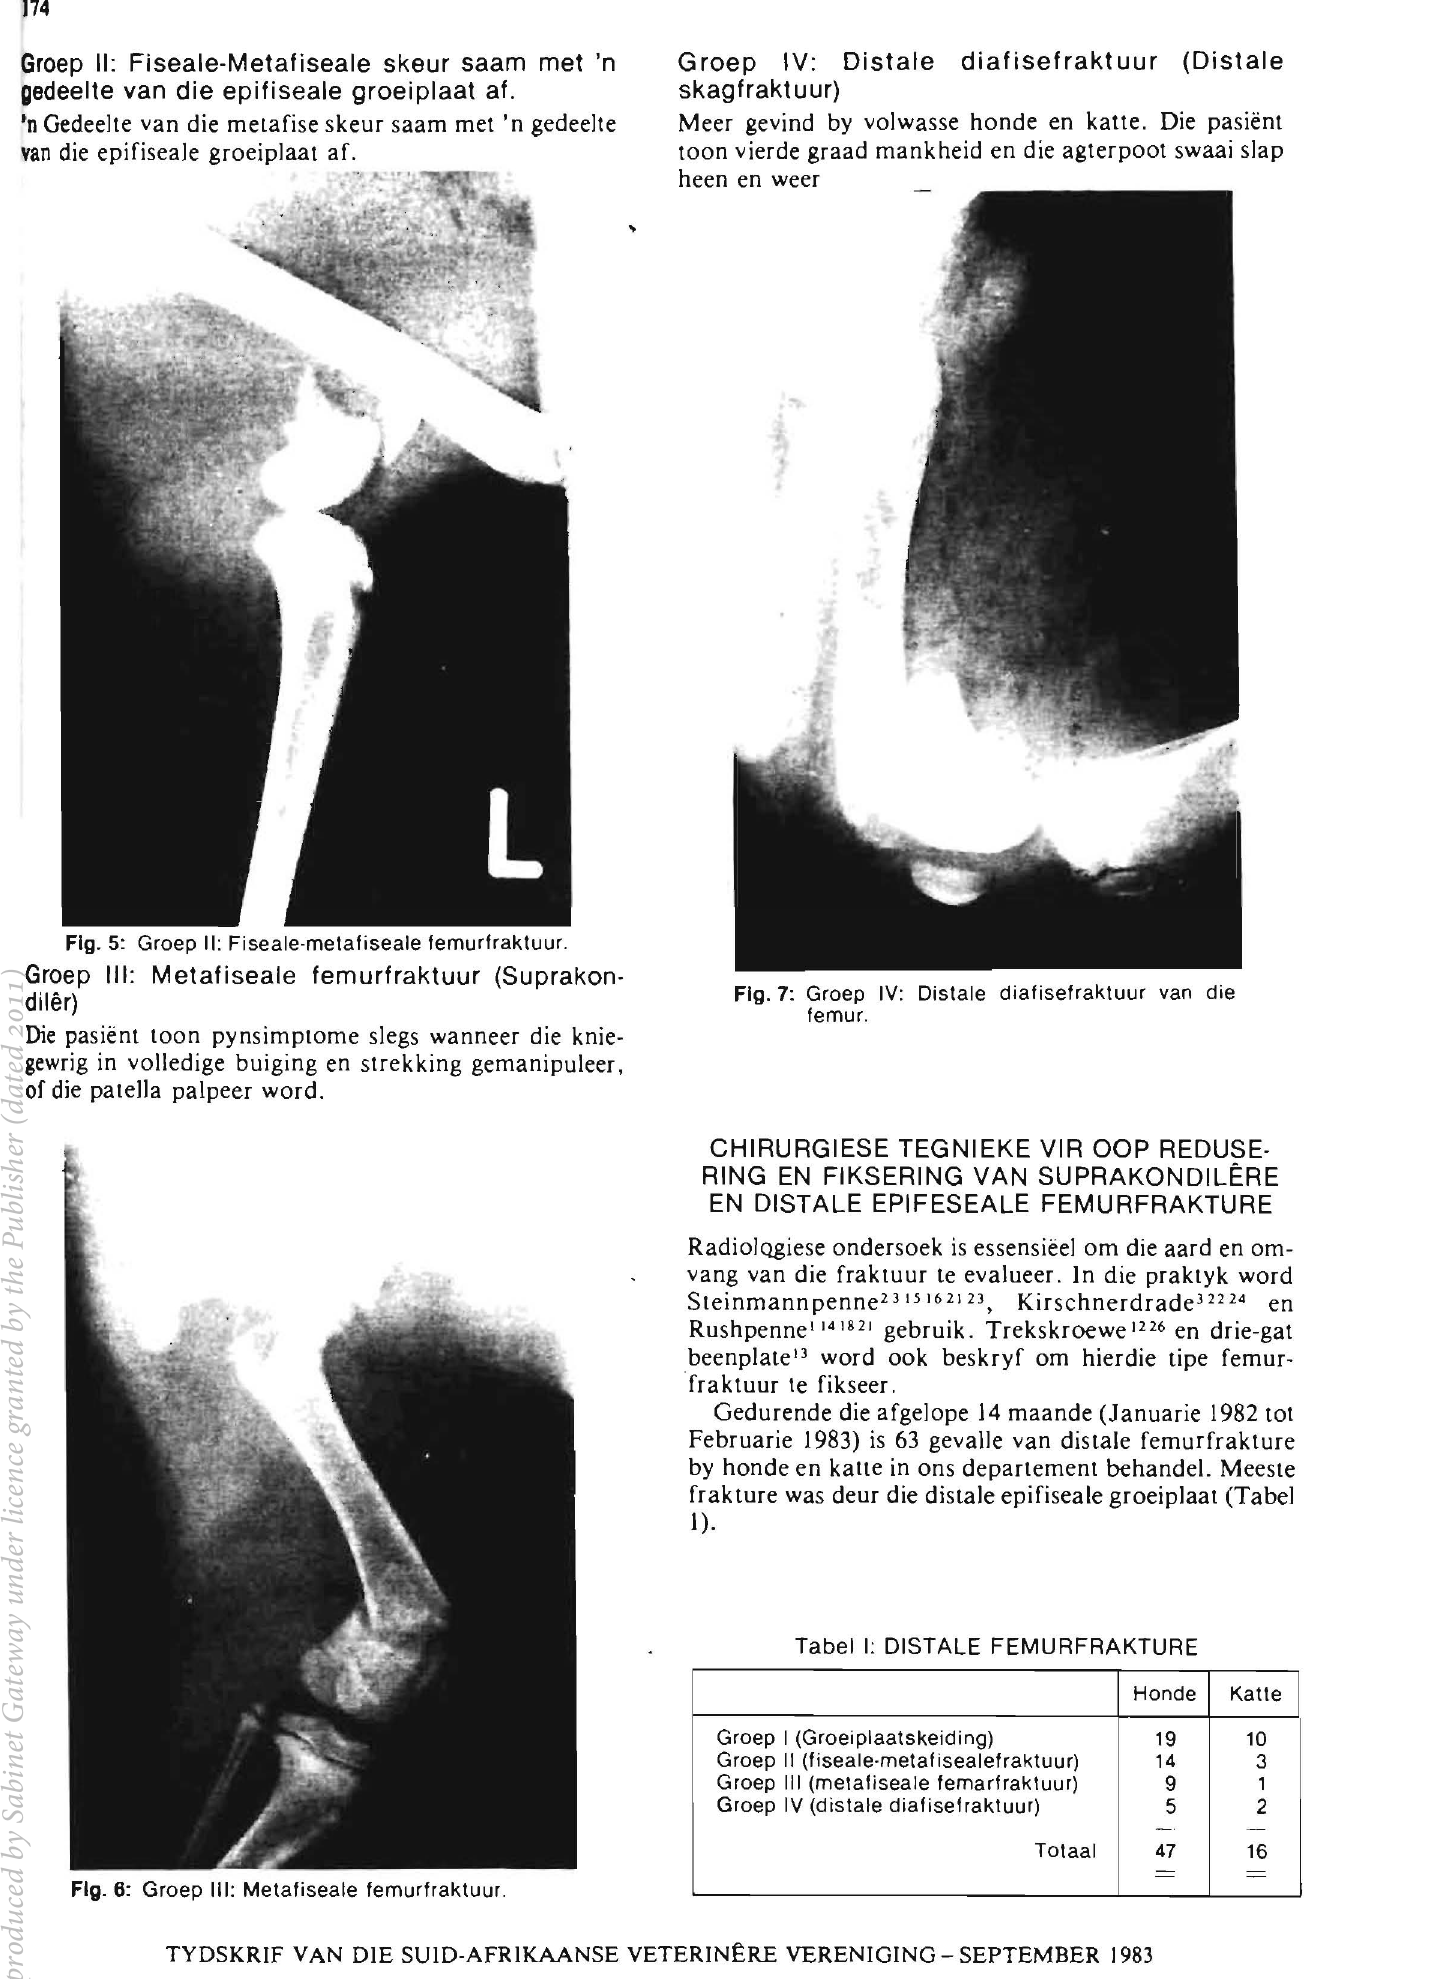
Fig. 6: Groep iii: Metafiseale femurfraktuur. TYDSKRIF VAN DIE SUID-AFRlKAANSE VETERINf.RE VERENIGING - SEPTEMBER 1983